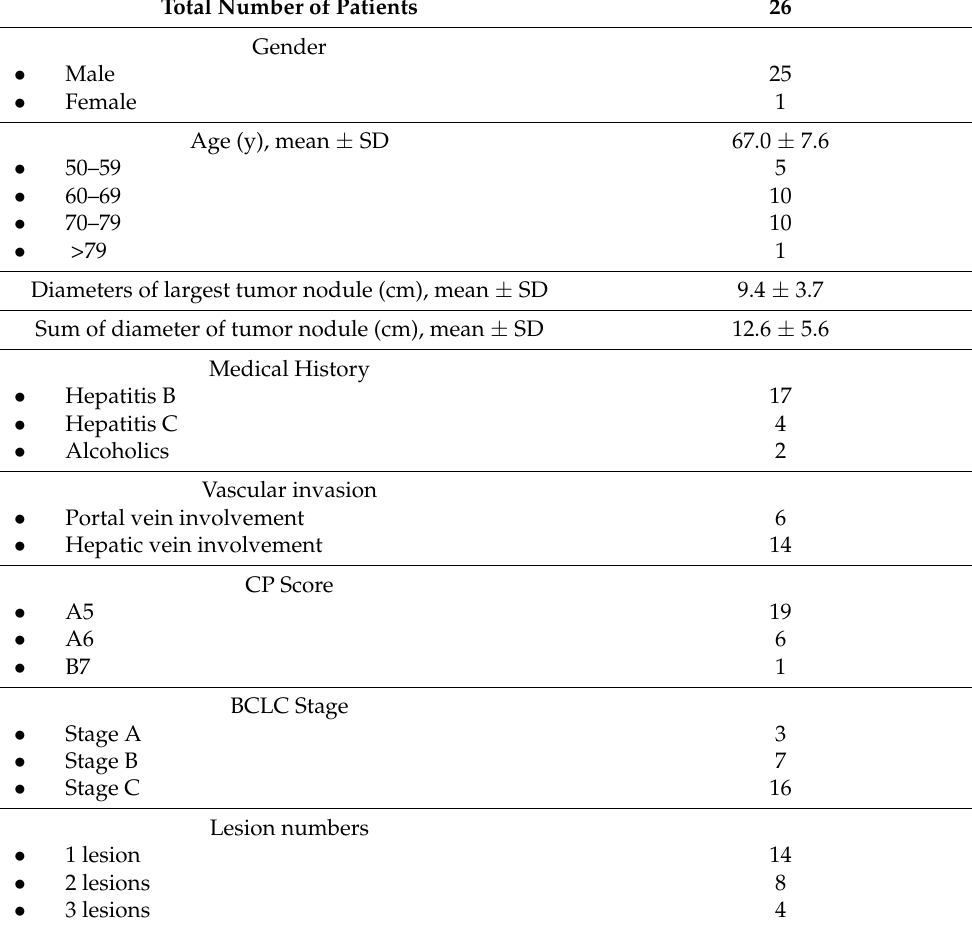
Table 1. Patient